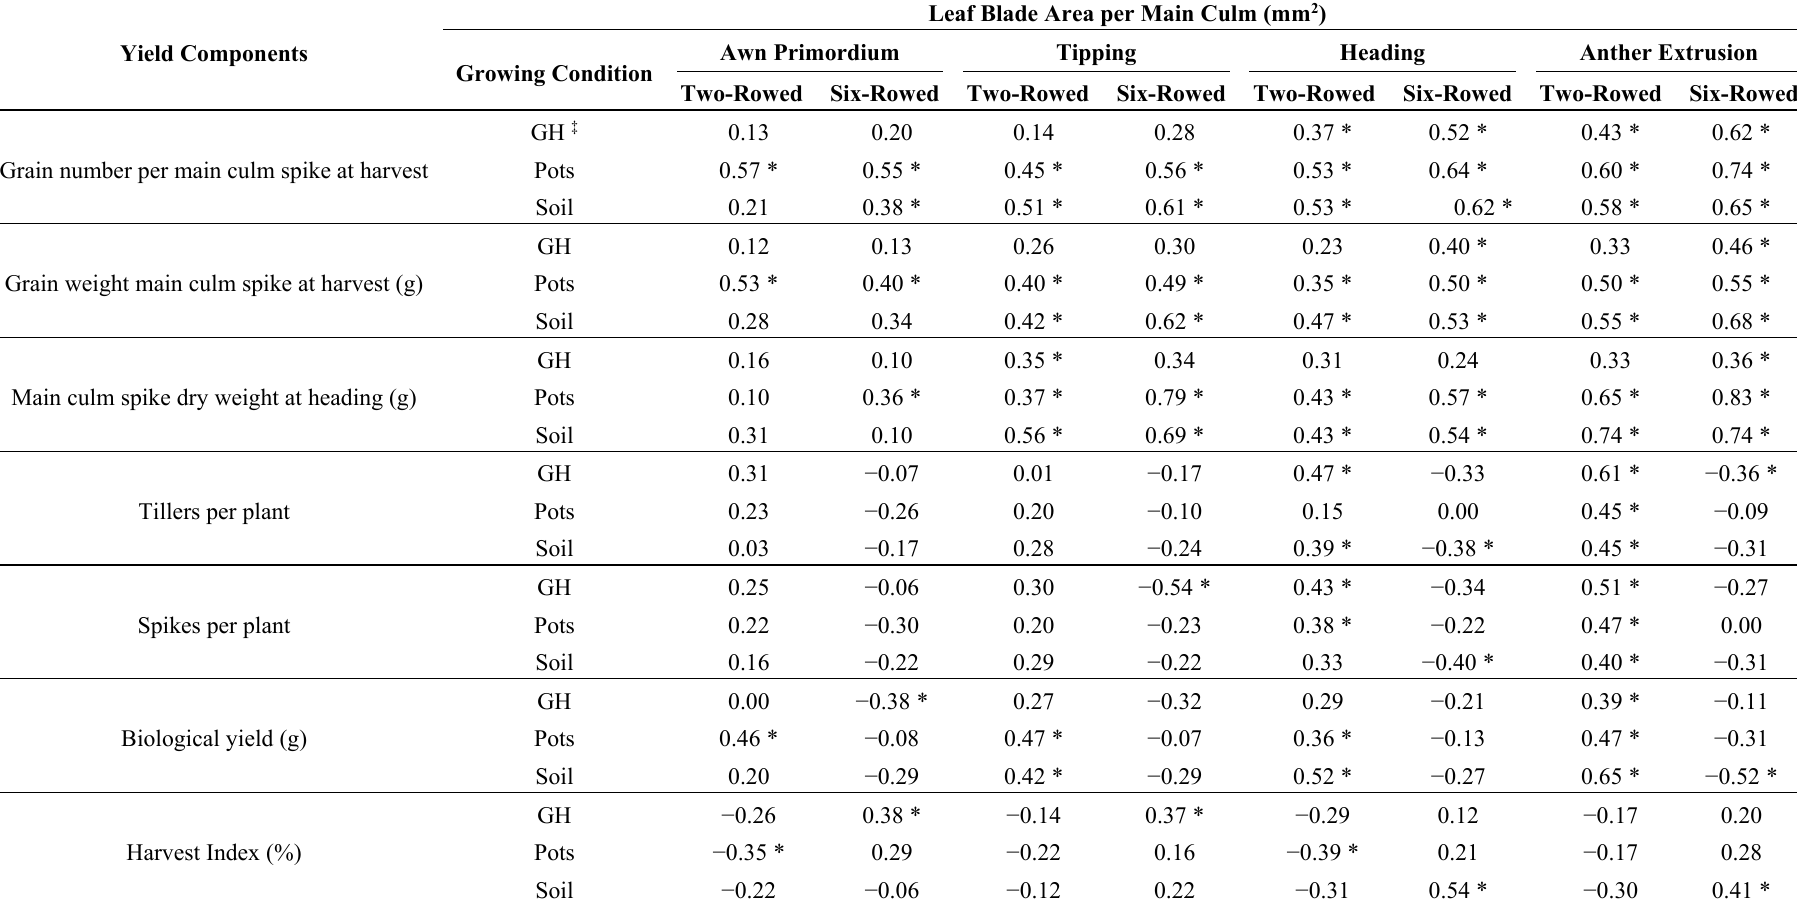
Table 2. Correlation coefficients between leaf blade area per main culm (mm 2 ) at different developmental stages with single-plant yield and yield components.